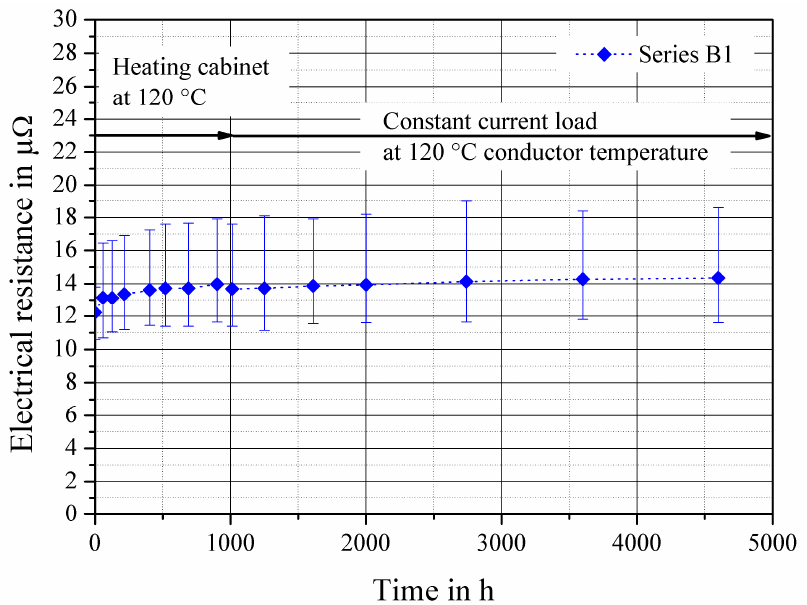
Figure 8. Electrical resistance (R 2 ) depends on the time in a heating cabinet at 120 ◦ C (continuous